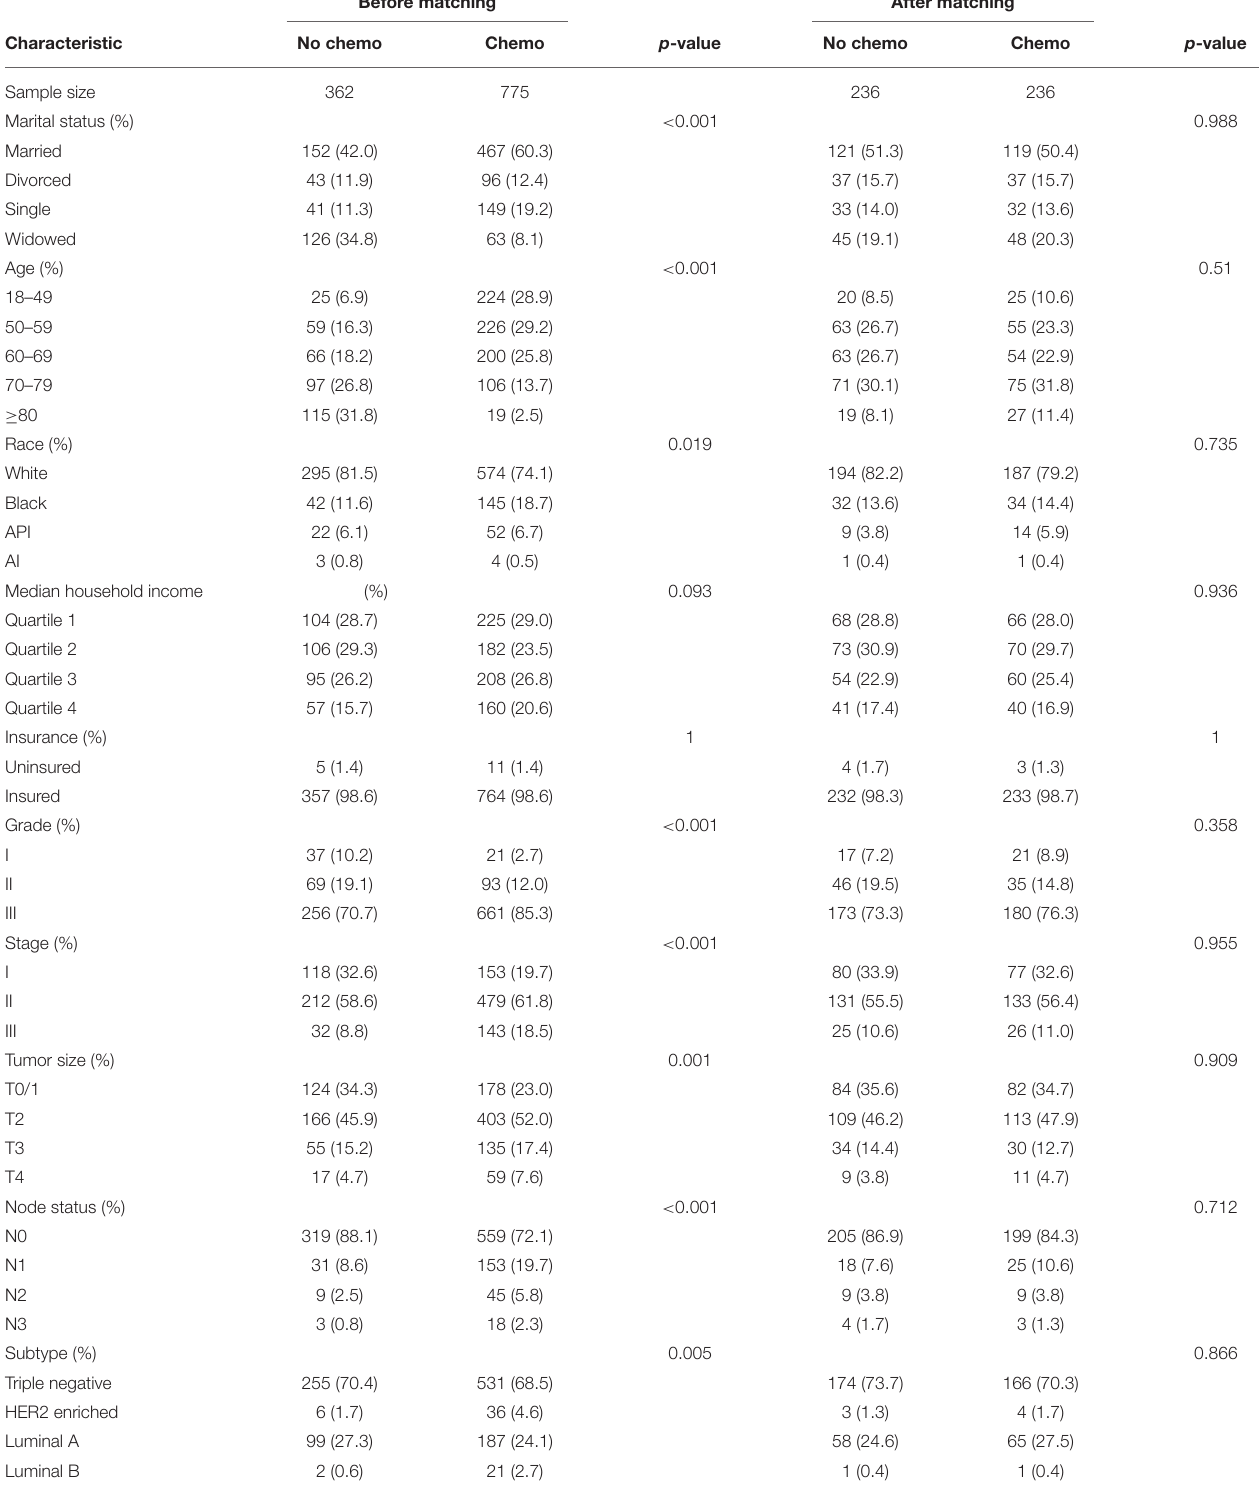
TABLE 1 | The descriptive characteristics of metaplastic breast cancer (MBC) before and after